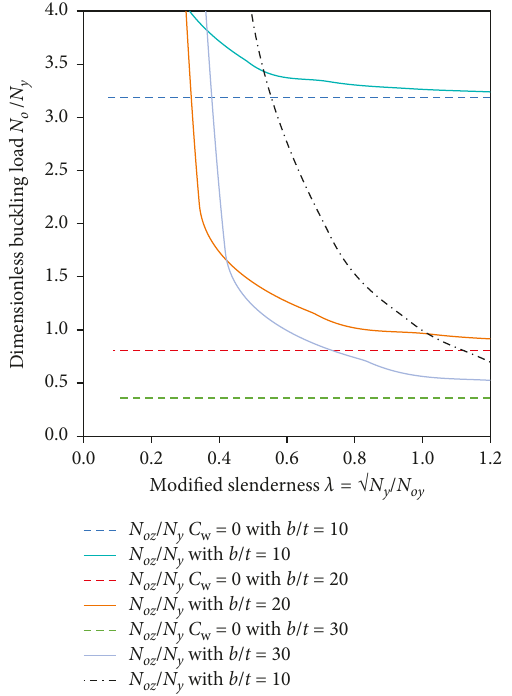
Figure 4: Torsional to flexural buckling loads for select plain cruciform members.